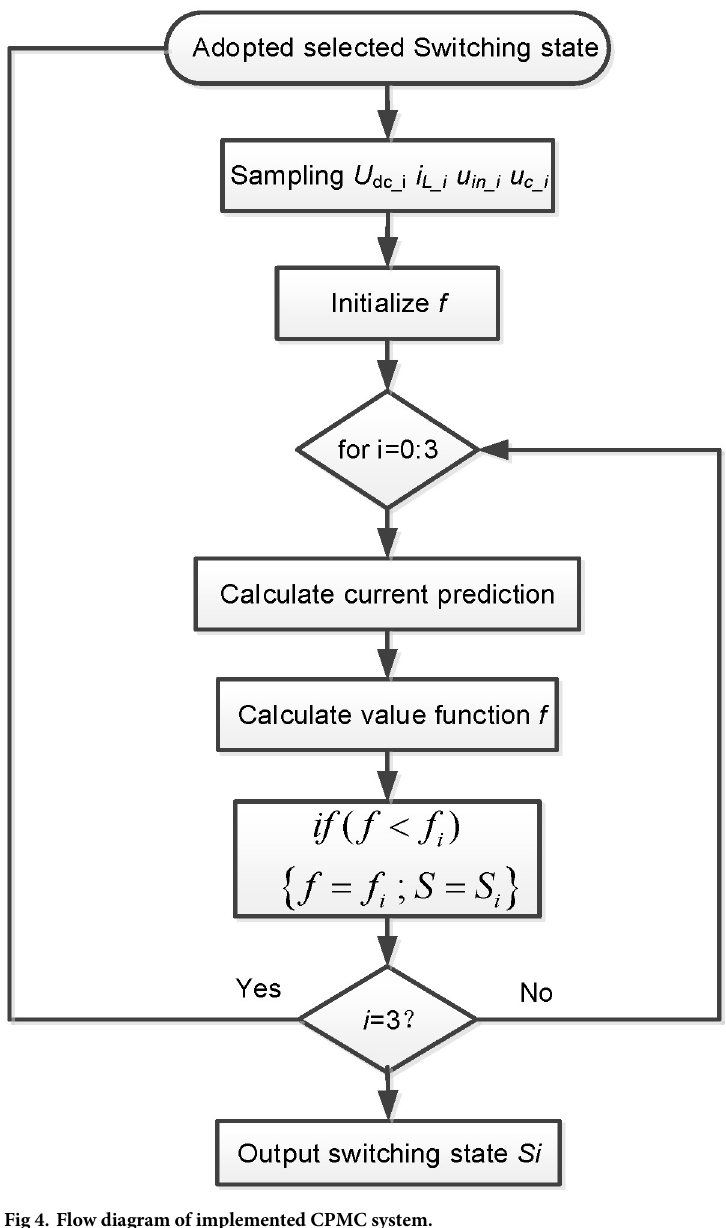
Fig 4. Flow diagram of implemented CPMC